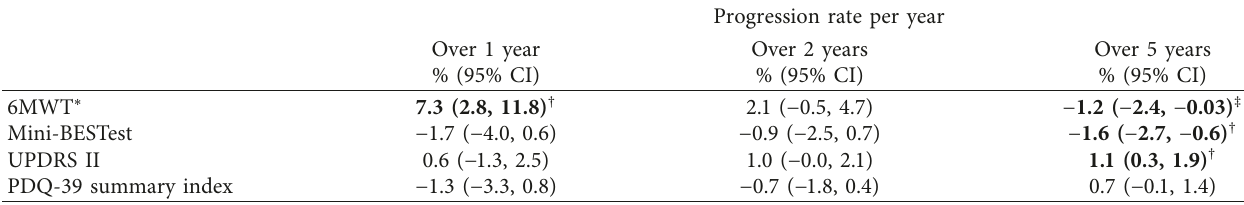
Table 3: Adjusted progression rates (in % of maximum score per year or % of baseline score per